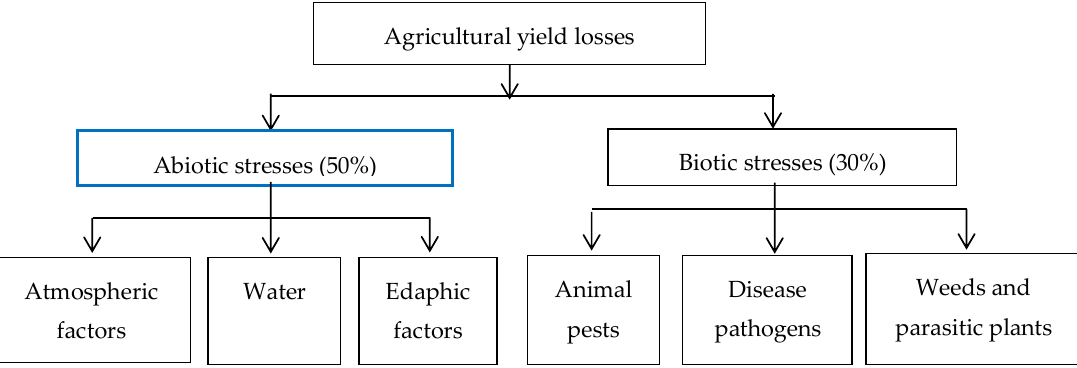
Agricultural yield losses